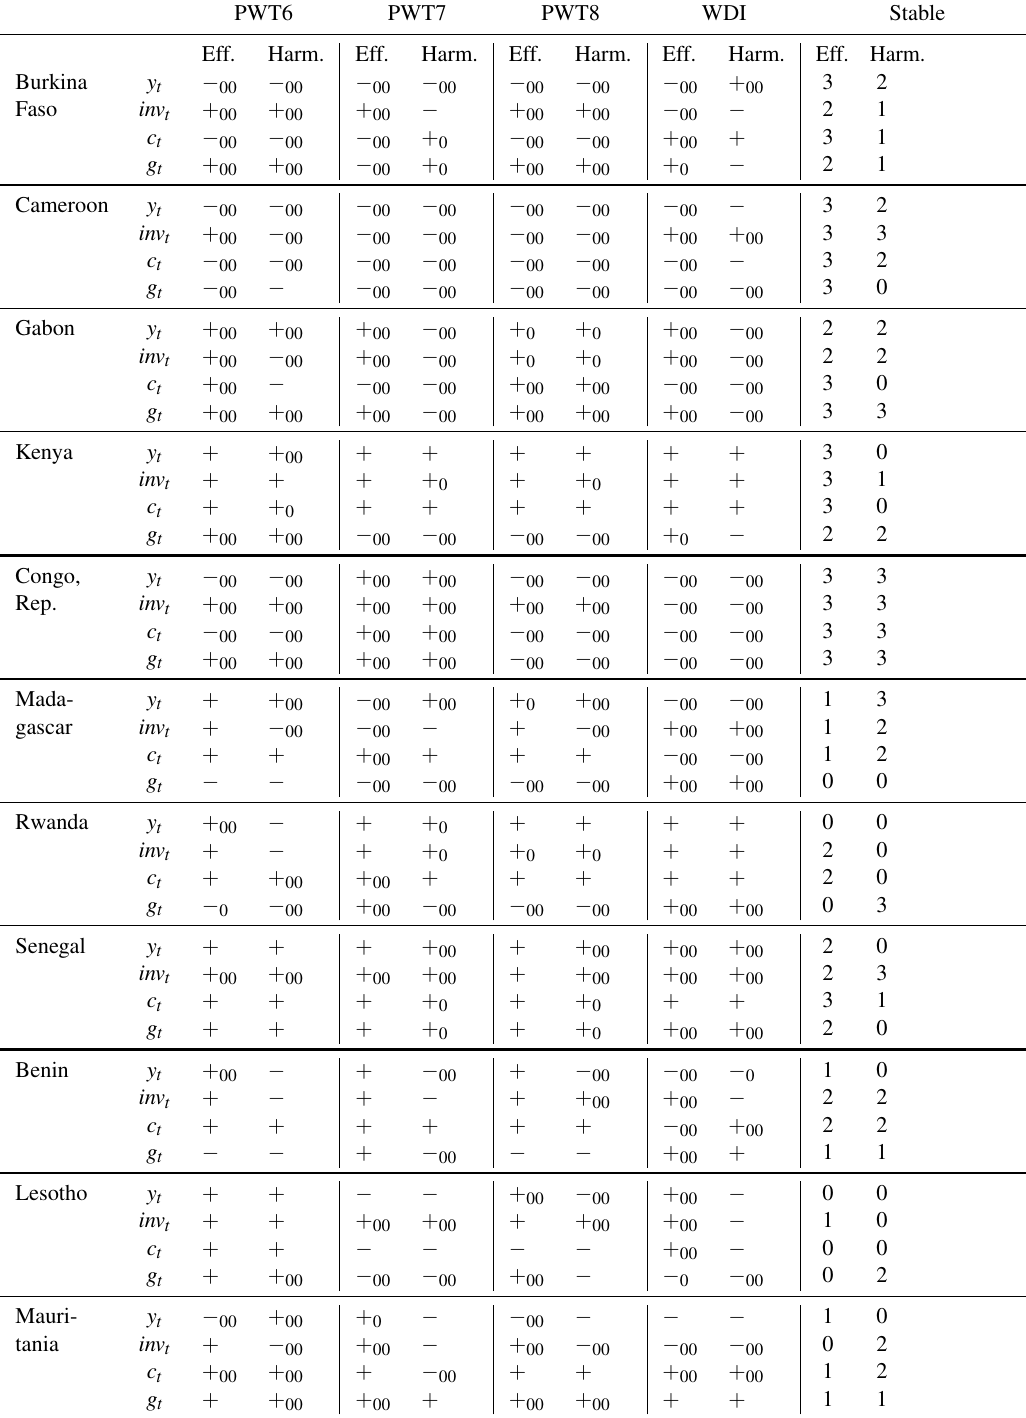
Table 10: Results of the re-specified